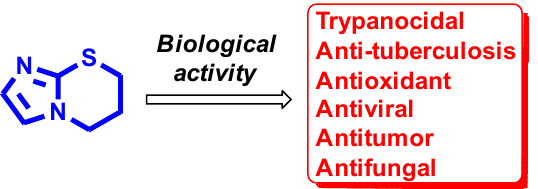
Figure 1. Pharmacology profile of imidazo[2,1- b ][1,3]thiazine scaffold.